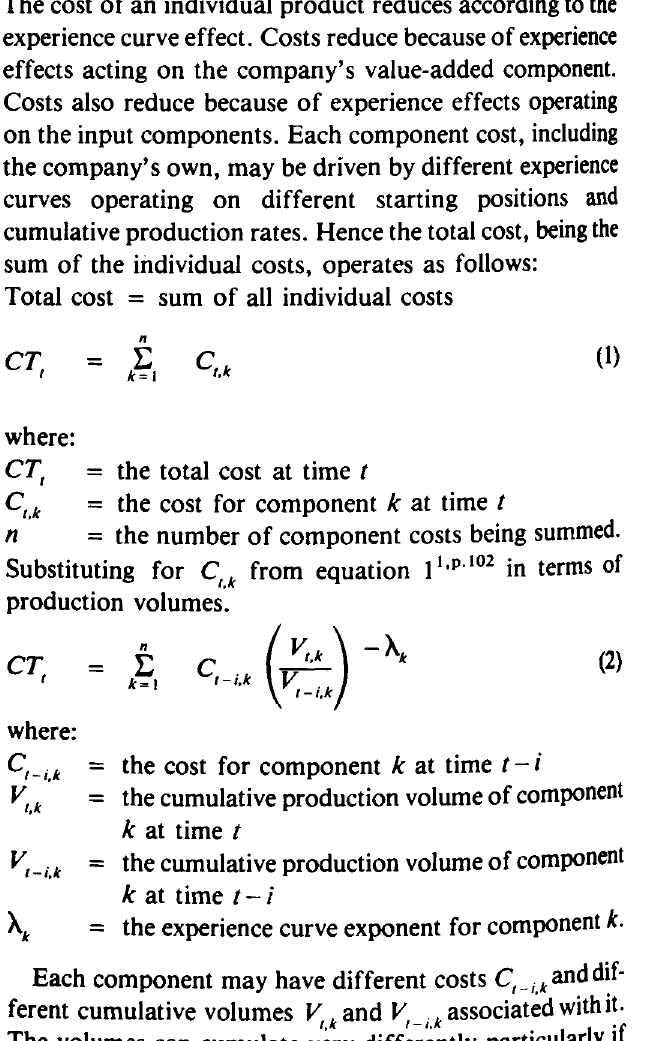
Figure 2 Price experience curve for the Japanese motorcycle industry (1959- )974) 14 ed to float freely. They are shored up, slide, glide, move cyclically, and sometimes abruptly devalue, thus changing the experience effect when measured in another